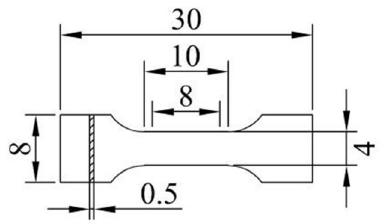
Figure 3. Dimensions of tensile specimens (unit: mm).